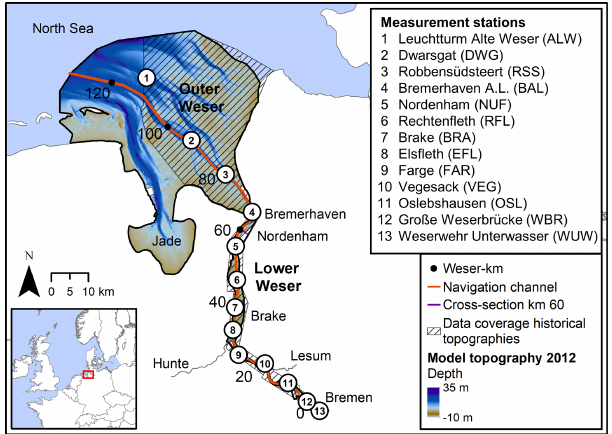
Figure 1. Map of the model area with the model topography 2012 displaying measurement stations and the distance along the naviga- tion channel from the tidal weir at Bremen (Weser-km). The hatched area shows the data coverage for historical